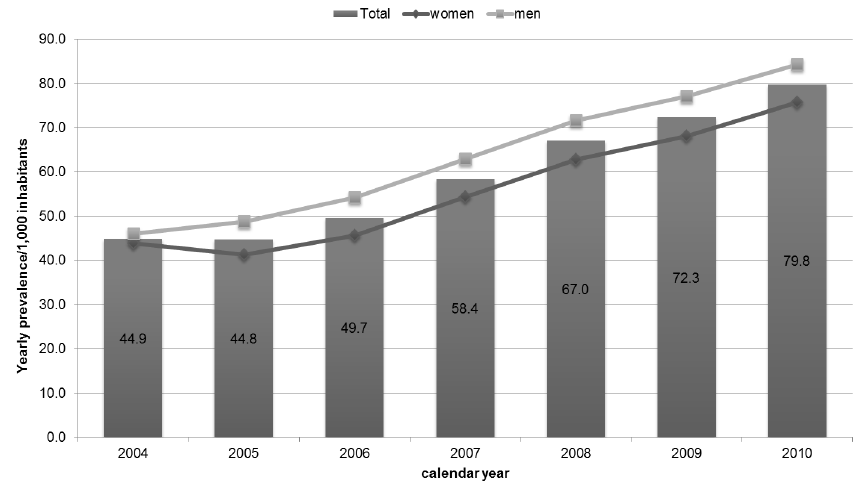
Figure 1. Yearly prevalence of statin use/1,000 inhabitants stratified by calendar year and gender.